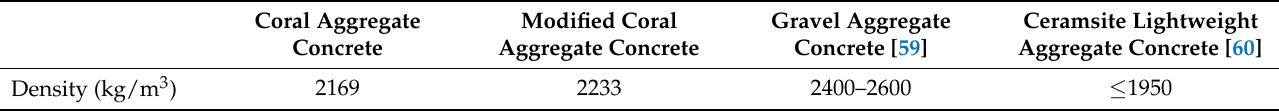
Table 7. Density of different kinds of